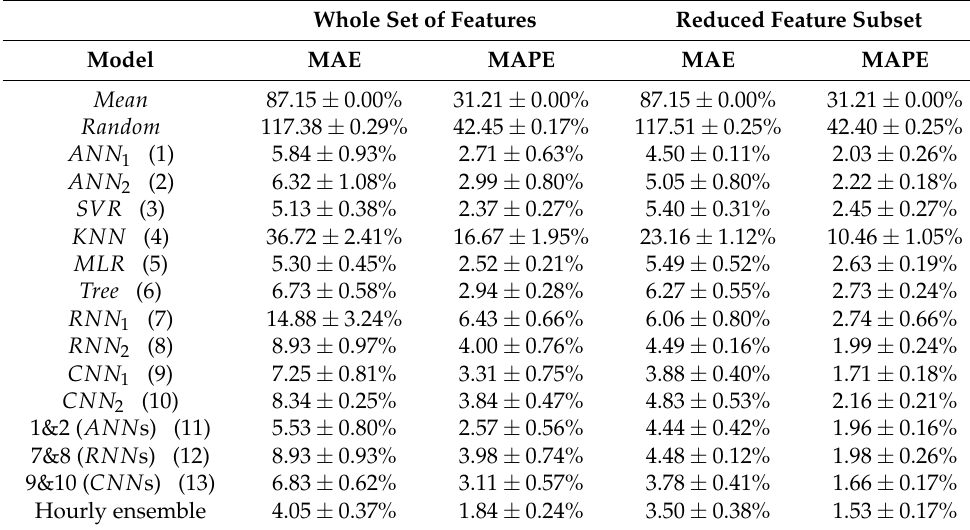
Table 1. Czech dataset hour-ahead load forecasting results.